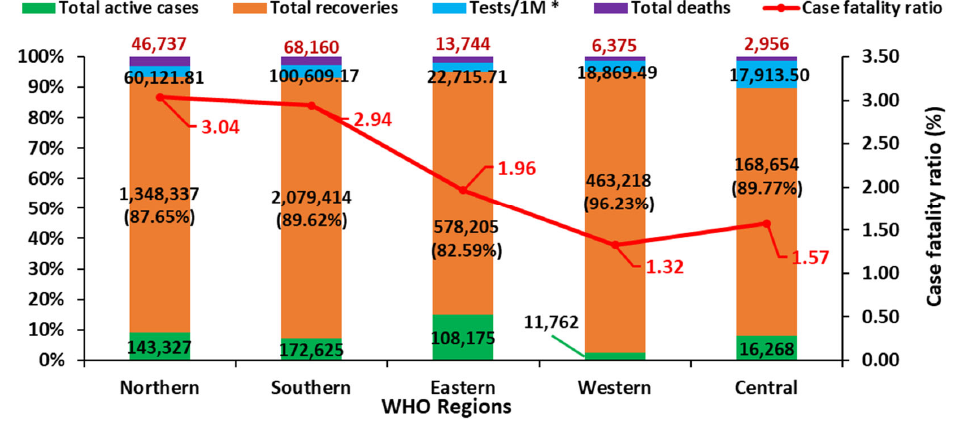
Figure 4. Overview of COVID ‐ 19 cases, death recoveries, test rates, and CFR in regions of Africa based on AU geographical grouping and Africa CDC data of 21 June 2021. * Tests per 1 million persons in the total population.